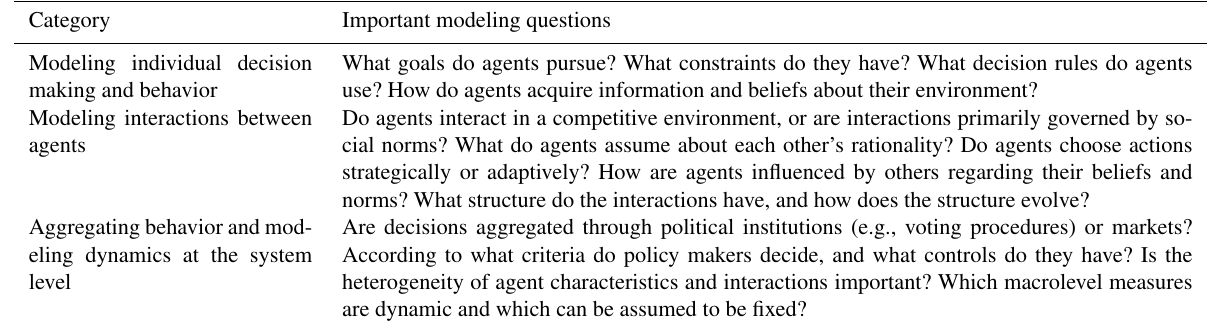
Table 5. Collection of questions that may guide the choice of modeling approaches and assumptions.